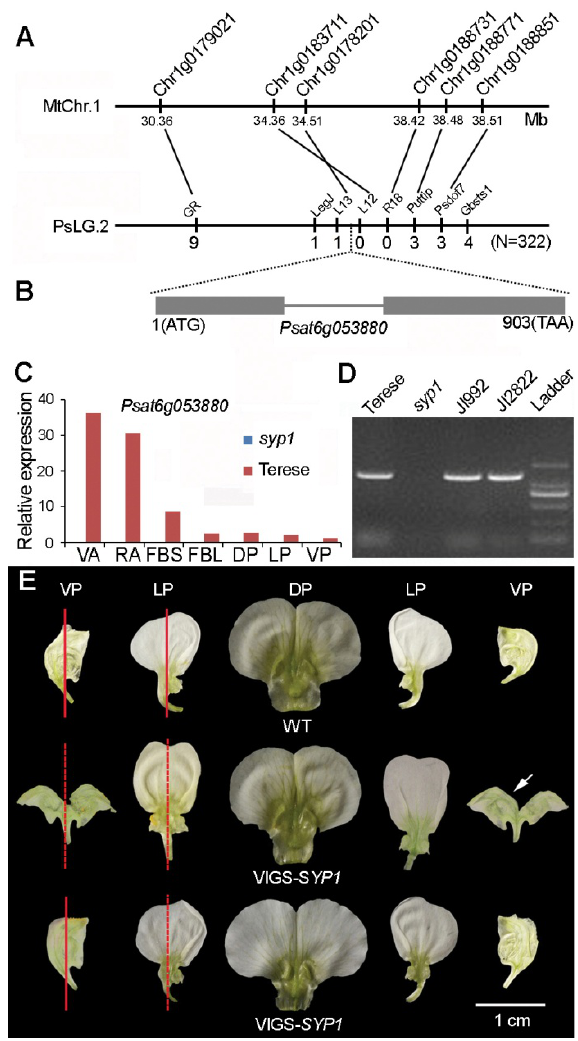
Figure 2. Molecular characterization of SYP1. ( A ) Comparative mapping and syntenic analysis of syp1 in pea and Medicago truncatula . The dotted lines indicate the homologous markers in the syntenic region. ( B ) The gene structure of Psat6g053880 . The black boxes represent the exons and the black line represents the intron. ( C ) The gene expression levels in the different organs of the syp1 mutant and the wild-type plants. ( D ) PCR amplification of the genomic fragment of Psat6g053880 in Terese, the syp1 mutant, JI992, and JI2822. ( E ) The lateral petals and ventral petals of the wild-type plants and VIGS -SYP1 silenced plants with strong and weak phenotypes. The red lines indicate the IN asymmetry and the dotted lines indicate the abolishment of IN asymmetry. VA, vegetative apices; RA, reproductive apices RA; FBS, 2-mm floral buds; FBL, 5-mm floral buds; DP, the dorsal petal; LP, the lateral petal; VP, the ventral petal.